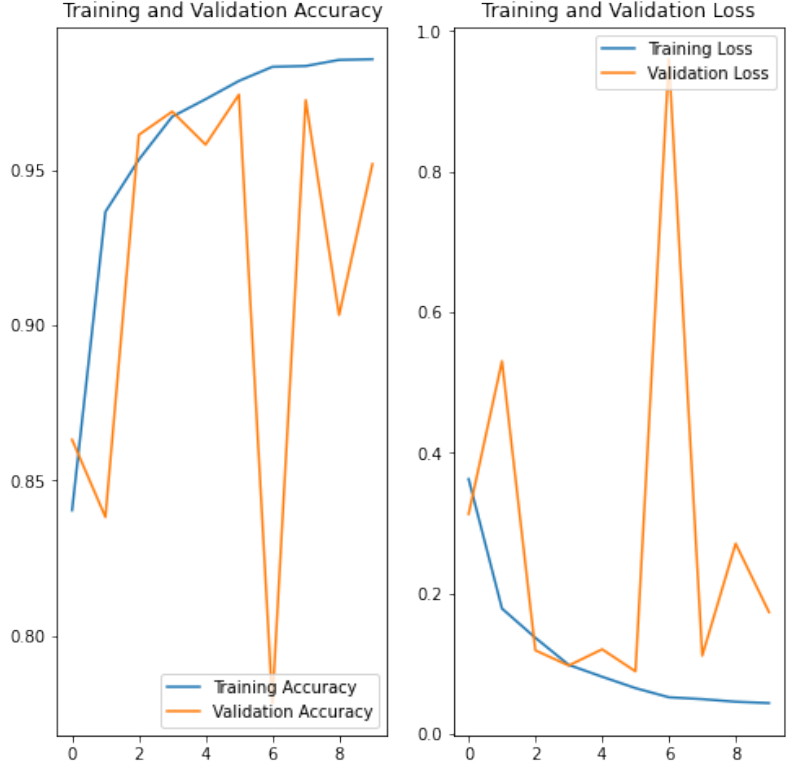
Figure 5. Validation accuracy and Training loss in Coco+ILSVR(205K) Model 2 & 104